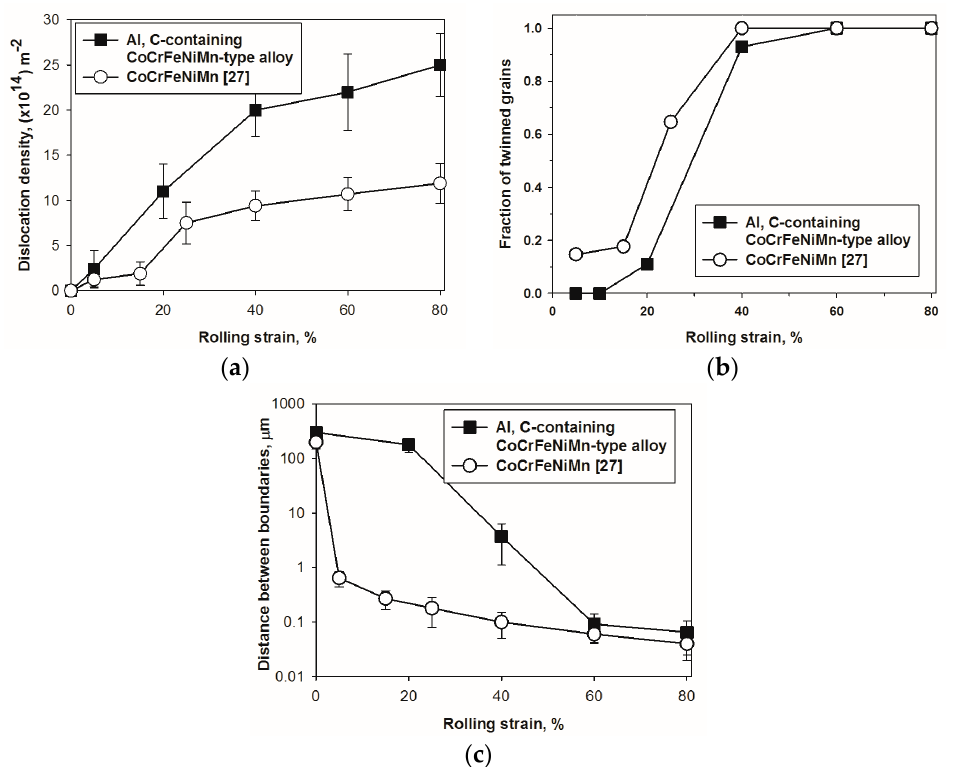
Figure 4. Dependence of ( a ) dislocation density; ( b ) fraction of twinned grains; and ( c ) distance between boundaries of the Al-, C-containing CoCrFeNiMn-type alloy on rolling strain. Data for the equiatomic CoCrFeNiMn alloy [27] is shown for comparison.